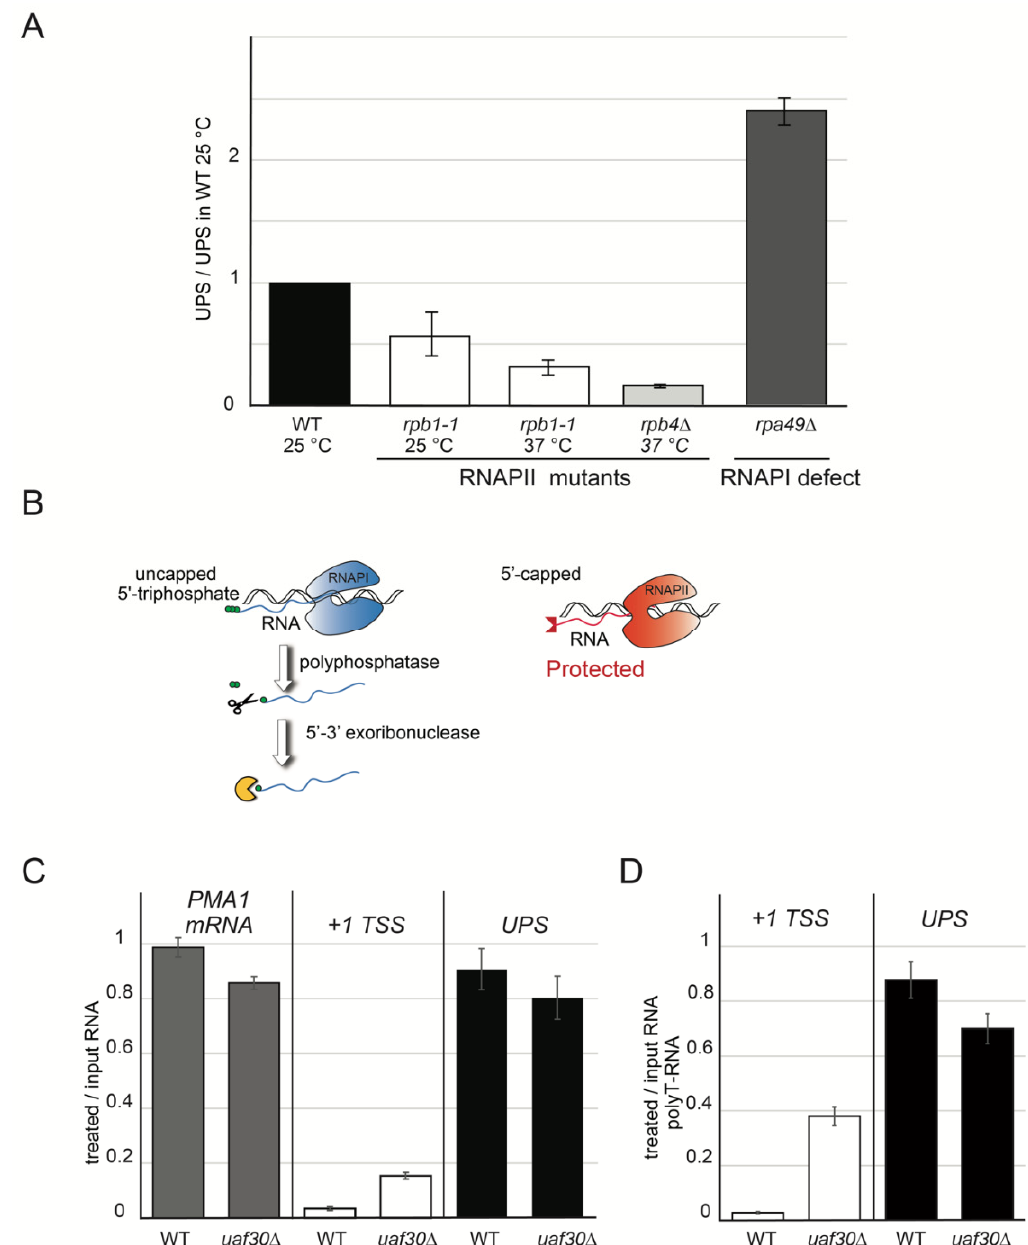
Figure 3. UPS are produced by RNAPII. ( A ) Quantities of UPS decreased in RNAPII mutants. RT-qPCR was performed on total RNA extracted from exponentially grown cultures grown at 25 ◦ C overnight shifted to 37 ◦ C for 1 h for rpb1-1 mutant. rpb4 ∆ and rpa49 ∆ mutants were processed at 30 ◦ C. rpb1-1 and rpb4 ∆ mutations provoke defects on RNAPII, and rpa49 ∆ was used for RNAPI repression conditions. Reverse transcription and qPCR were performed as in Figure 1C for UPS, but specific scR1-R primer was added for internal normalization. Error bars correspond to the standard deviation of three independent cultures. All values were normalized by WT 25 ◦ C values. ( B ) Principles of RNA protection assay. Transcribing RNAPII is in red, and RNAPI is in blue. Terminal 5 (cid:48) -triphosphates of RNAPI-specific transcripts are presented as green circles and RNAPII-specific cap as red triangles. Subsequent steps of in vitro treatment are as follows: polyphosphatase depicted as scissors and 5 (cid:48) -3 (cid:48) exoribonuclease as a yellow Pacman. ( C ) UPS transcripts are capped. Total RNA from wild-type and uaf30 ∆ mutated strains (BY4741) were treated as depicted in ( B ). Reverse transcription was performed using random primers. UPS and +1 TSS were quantified as described in Figure 1C, and PMA1 mRNA was amplified with its specific primers. Values are depicted as ratios of treated versus untreated RNAs. Error bars represent the standard deviation of three independent measurements. ( D ) UPS transcripts are polyadenylated. The experiment and quantification were performed as in ( C ) but reverse-transcribed using polyT oligonucleotides in order to amplify polyadenylated transcripts.